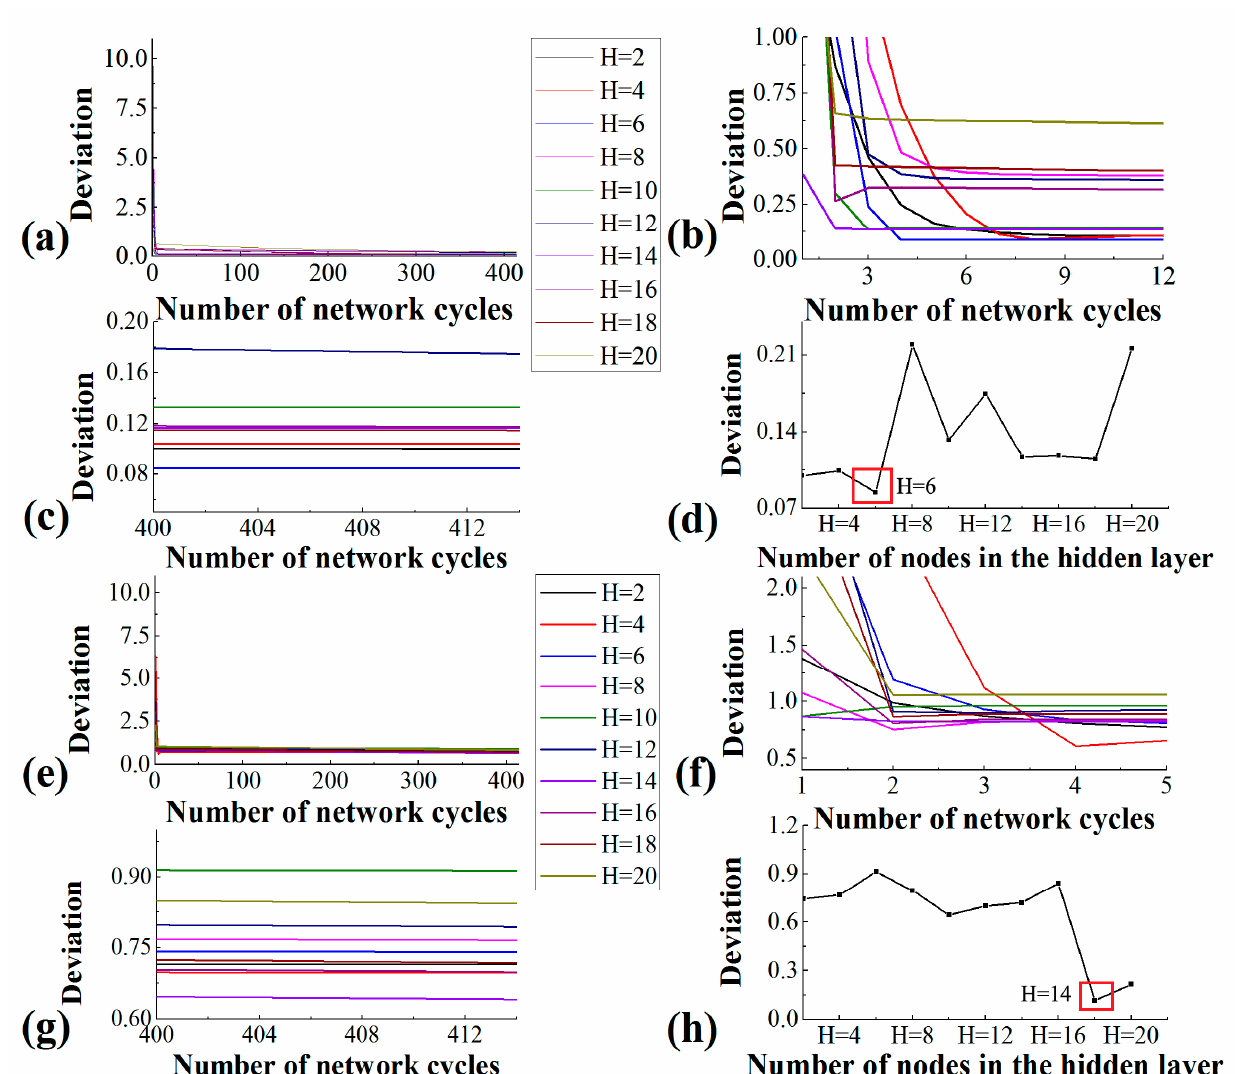
Figure 1. The variation of deviation during network cycles in the MFS + BPNN and PROSAIL + BPNN. ( a ) The variation of deviation during network cycle in the MFS + BPNN, ( b ) the most obvious position for deviation reduction in MFS + BPNN, ( c ) the deviation of the MFS + BPNN at the last few cycles, and ( d ) the deviation of the MFS + BPNN at the last cycle, ( e ) the variation of deviation during network cycle in MFS + BPNN, ( f ) the most obvious position for deviation reduction in the MFS + BPNN, ( g ) the deviation of the MFS + BPNN at the last few cycles, and ( h ) the deviation of the MFS + BPNN at the last cycle. Here, red boxes in Figure 1d,h are the number of nodes in the hidden layer when the deviation is minimum, and the symbol H is an abbreviation for the number of nodes in the hidden layer. Table 2. The input parameters of the BPNNs in the program.